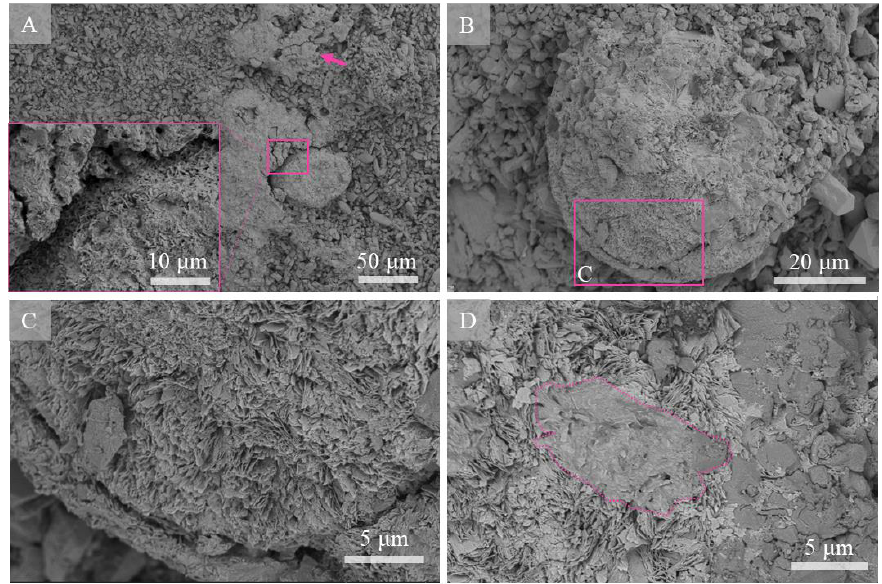
Figure 4. SEM images reveal the distribution of manganic minerals and carbonate micrite. ( A ) Laminated Mn oxide (arrow) and spherical shapes are encrusted on the micrite. Inset shows that the typical layer structure was well developed in a spherical shape compared with encrusted layers. ( B ) Sub-spherical Mn oxides commingling with carbonate. ( C ) Enlarged view of selected area in ( B ) shows the lamellar shape with clear interface; ( D ) Mn oxide with laminar shape filled in the space of carbonate. Carbonate cements mixed with Mn oxide at the center of the Mn oxide (dotted outline).